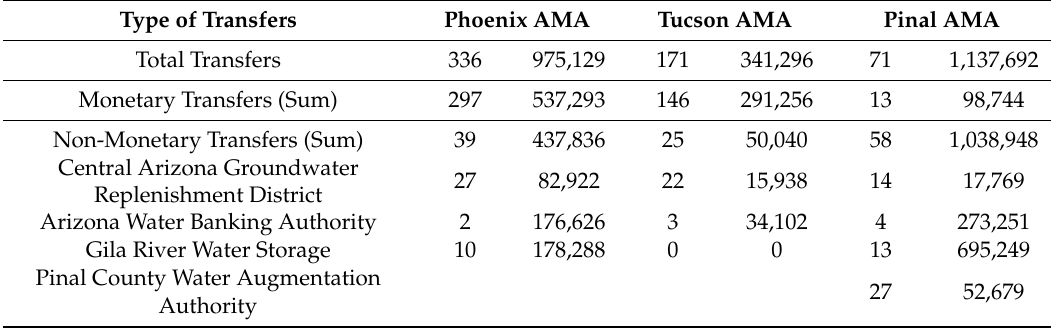
Table 2. Number of transfers and volume of Arizona’s long-term storage credit transfers, from 1994 to